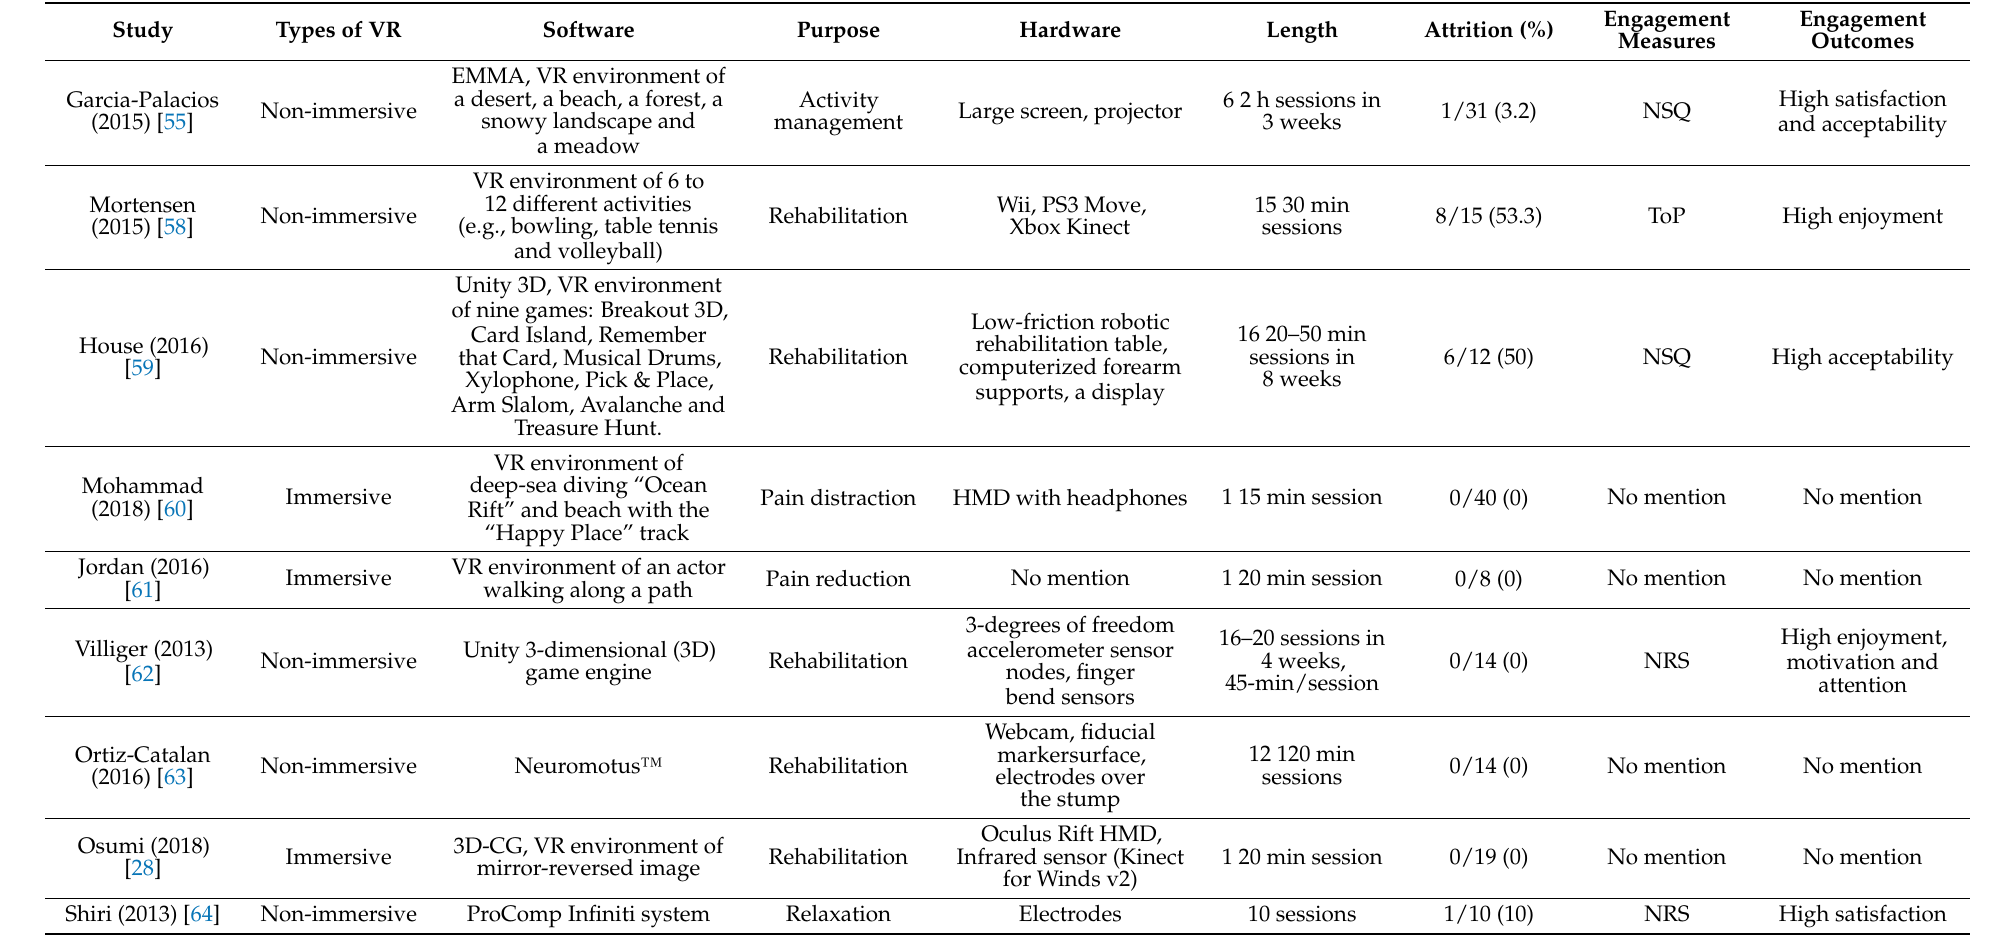
Table 4. Details of the VR-based interventions and user engagement measure